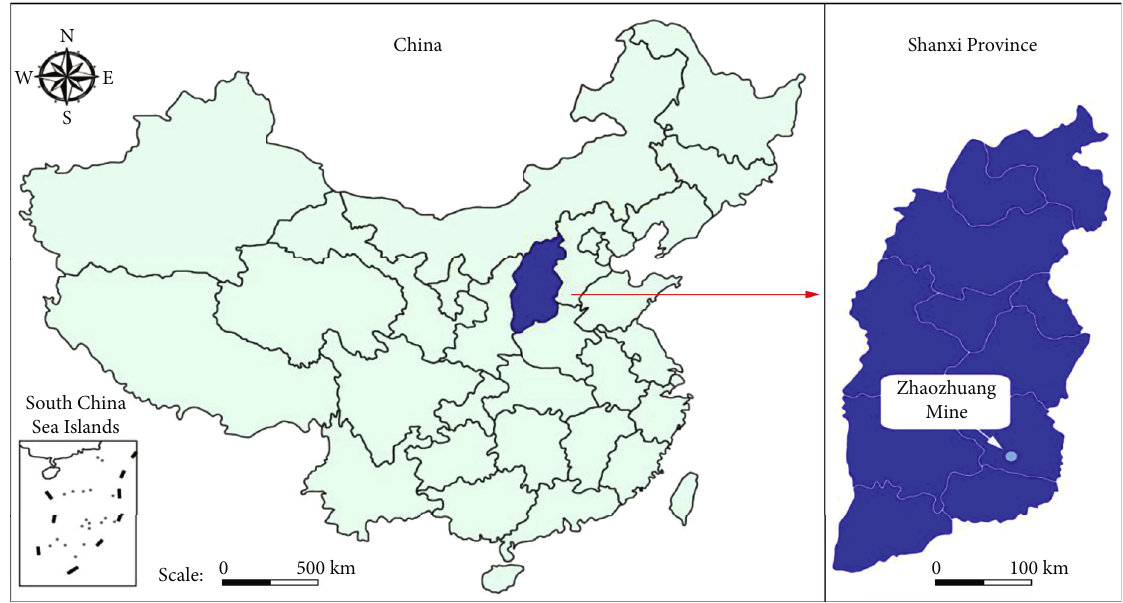
Figure 1: Location of Zhaozhuang Mine.